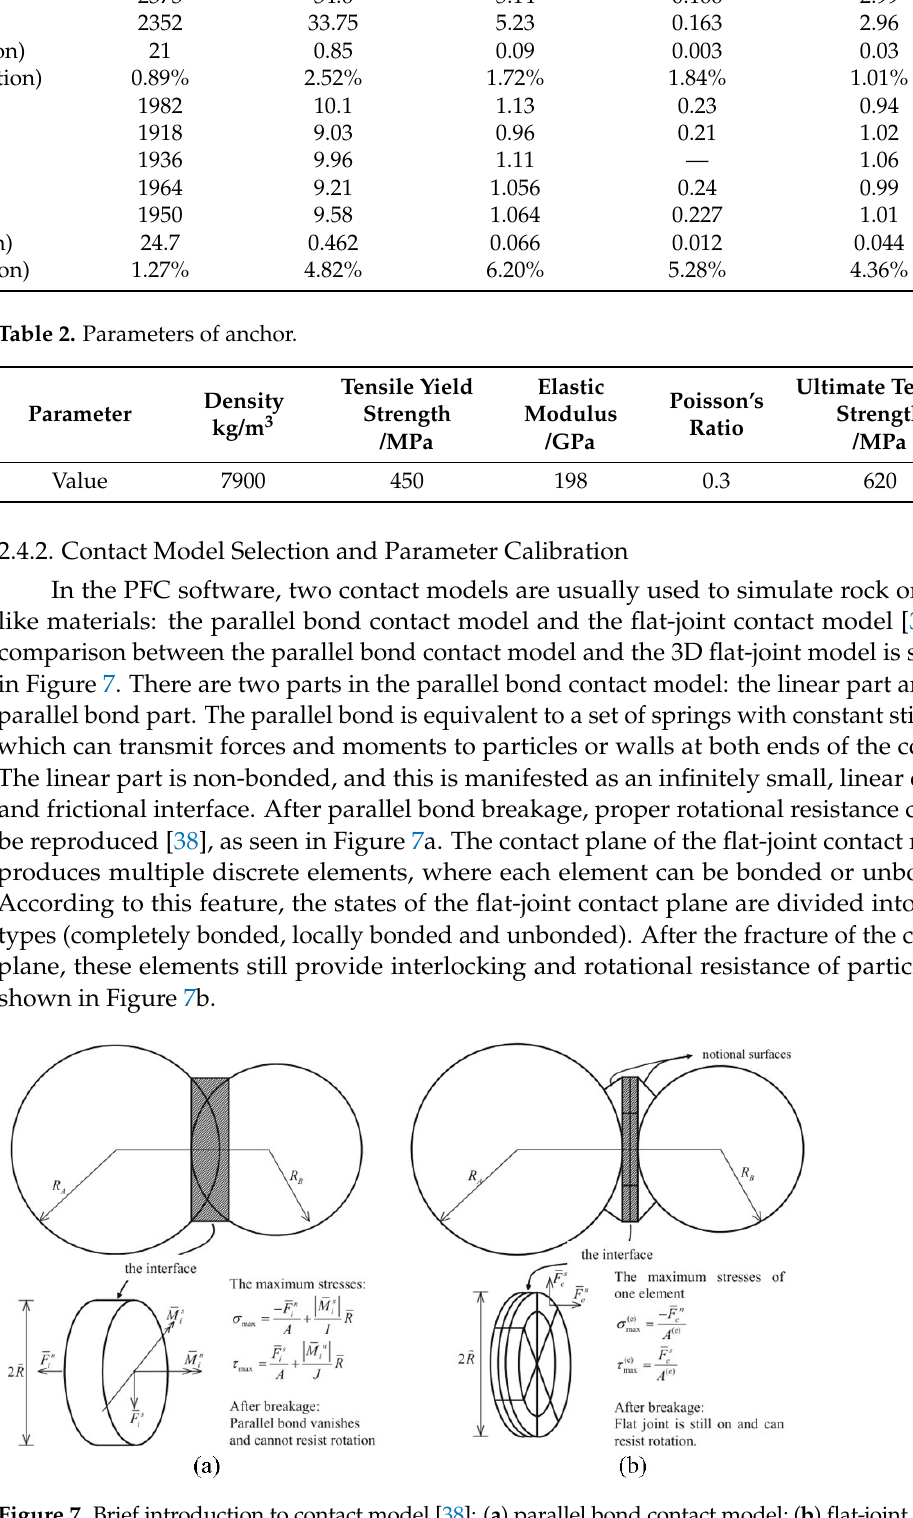
Figure 7. Brief introduction to contact model [38]: ( a ) parallel bond contact model; ( b ) flat-joint model.